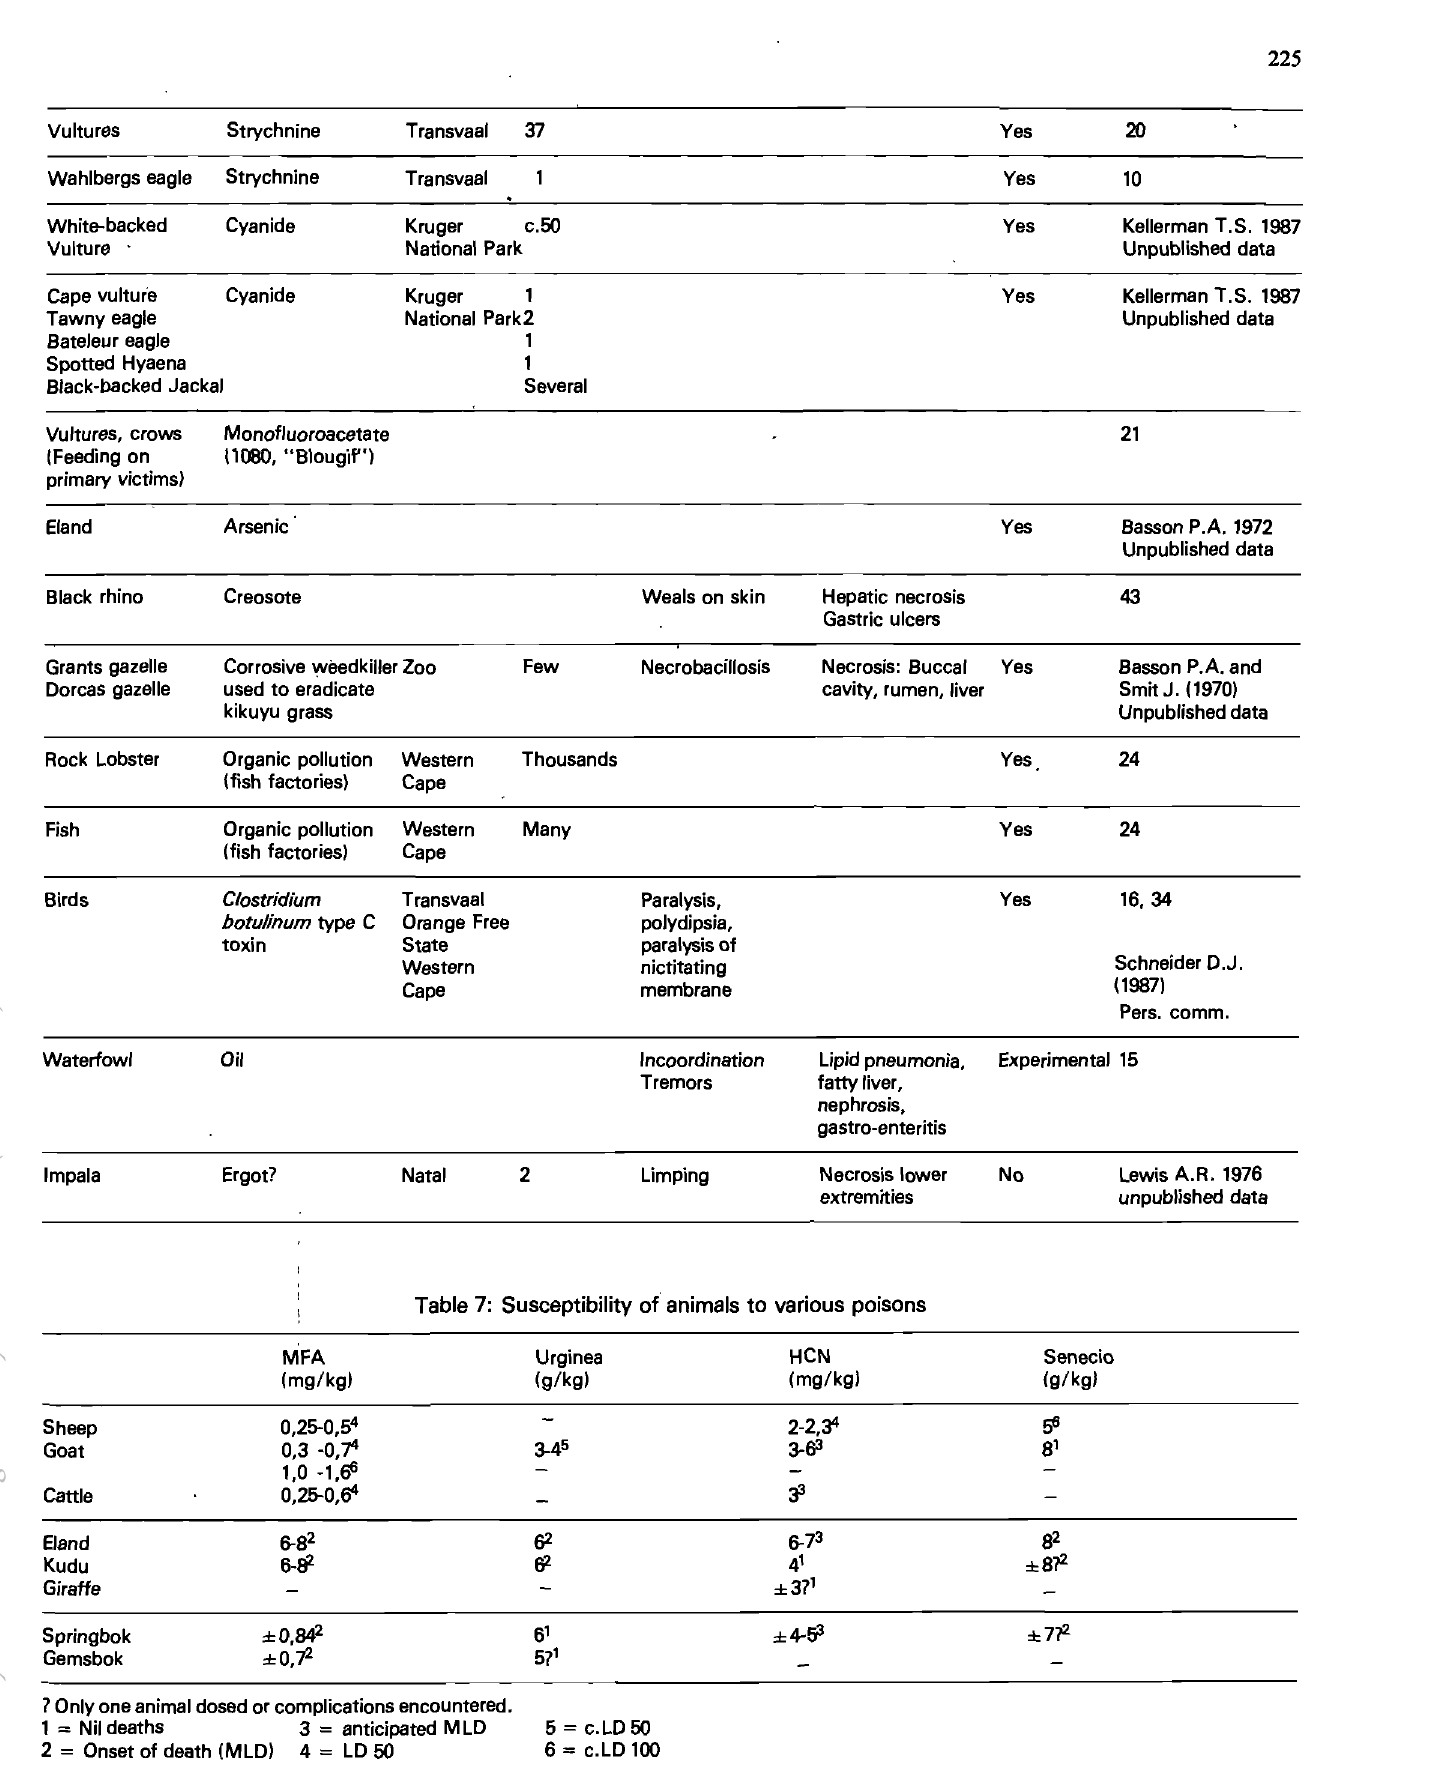
Table 7: Susceptibility of animals to various